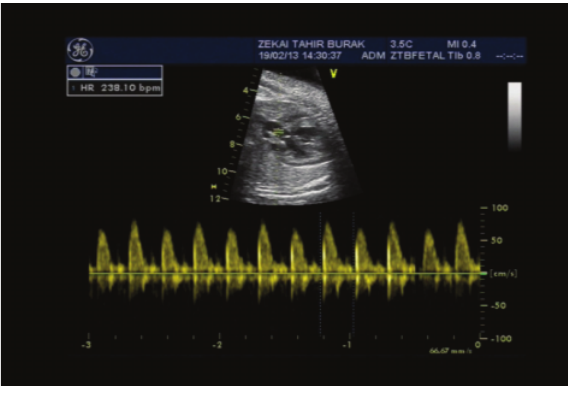
Figure 1: M-mode imaging is demonstrating a heart rate of 238